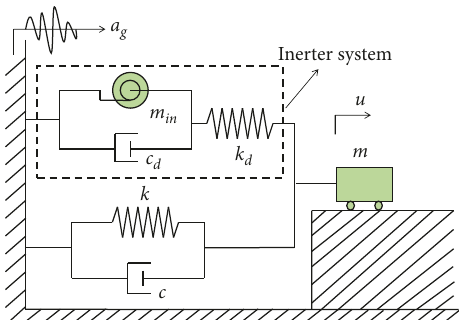
Figure 1: Mechanical model of an SDOF system with the inerter